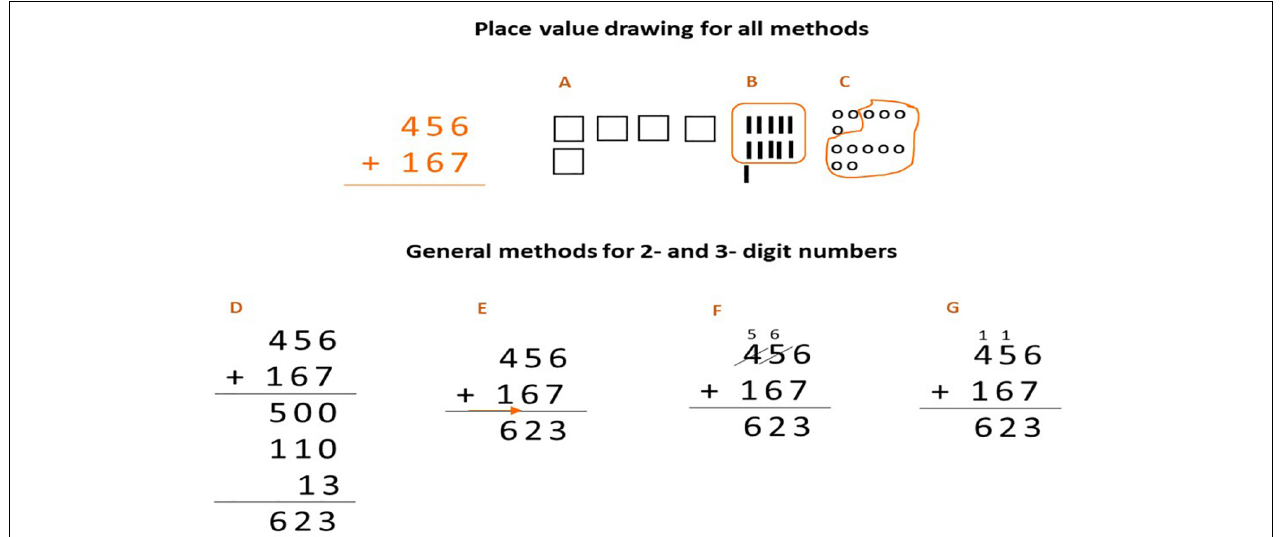
FIGURE 3 | Alternative addition algorithms used in the United States’s education system. Source: Fuson and Beckmann (2013, p. 19). Methods (A,B) variations of what is counted or added on first are possible, and the number of steps involved could vary. Method (C) keeps track numerically rather than with a drawing. Methods (D–G) are all variations in the standard algorithm, but Method (D) is conceptually clearer and easier.